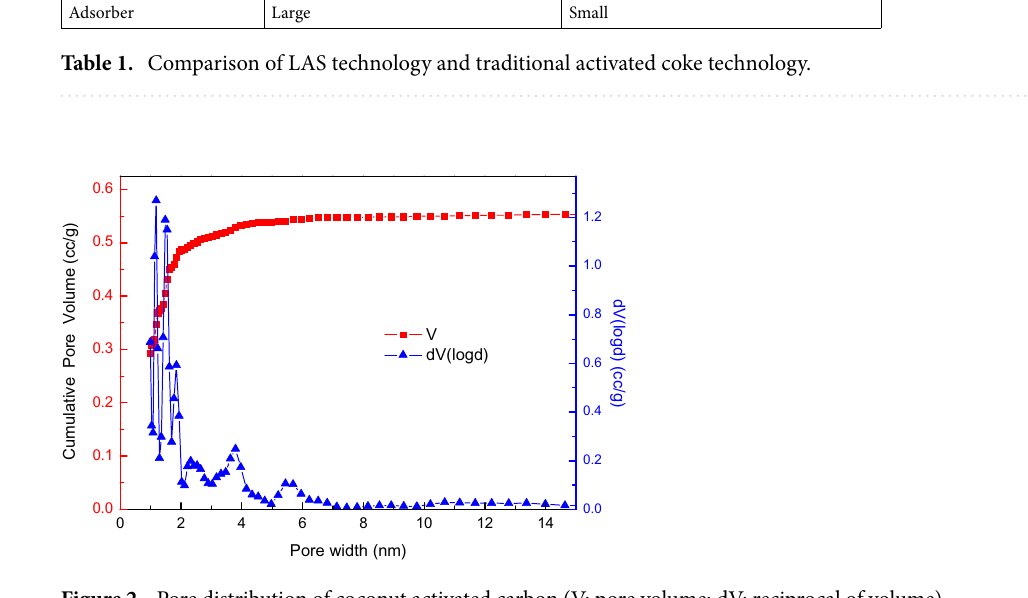
Figure 2. Pore distribution of coconut activated carbon (V: pore volume; dV: reciprocal of volume).